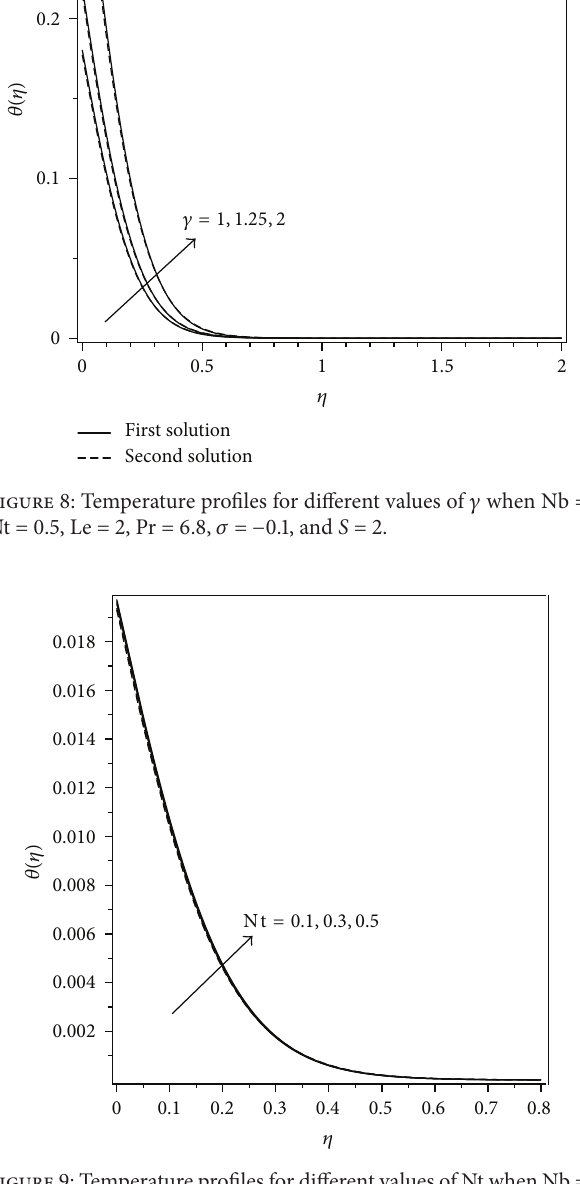
Figure 9: Temperature profiles for different values of Nt when Nb = 0.5, Le = 2, Pr = 6.8, 𝛾 = 0.1, 𝜎 = − 0.1, and S =